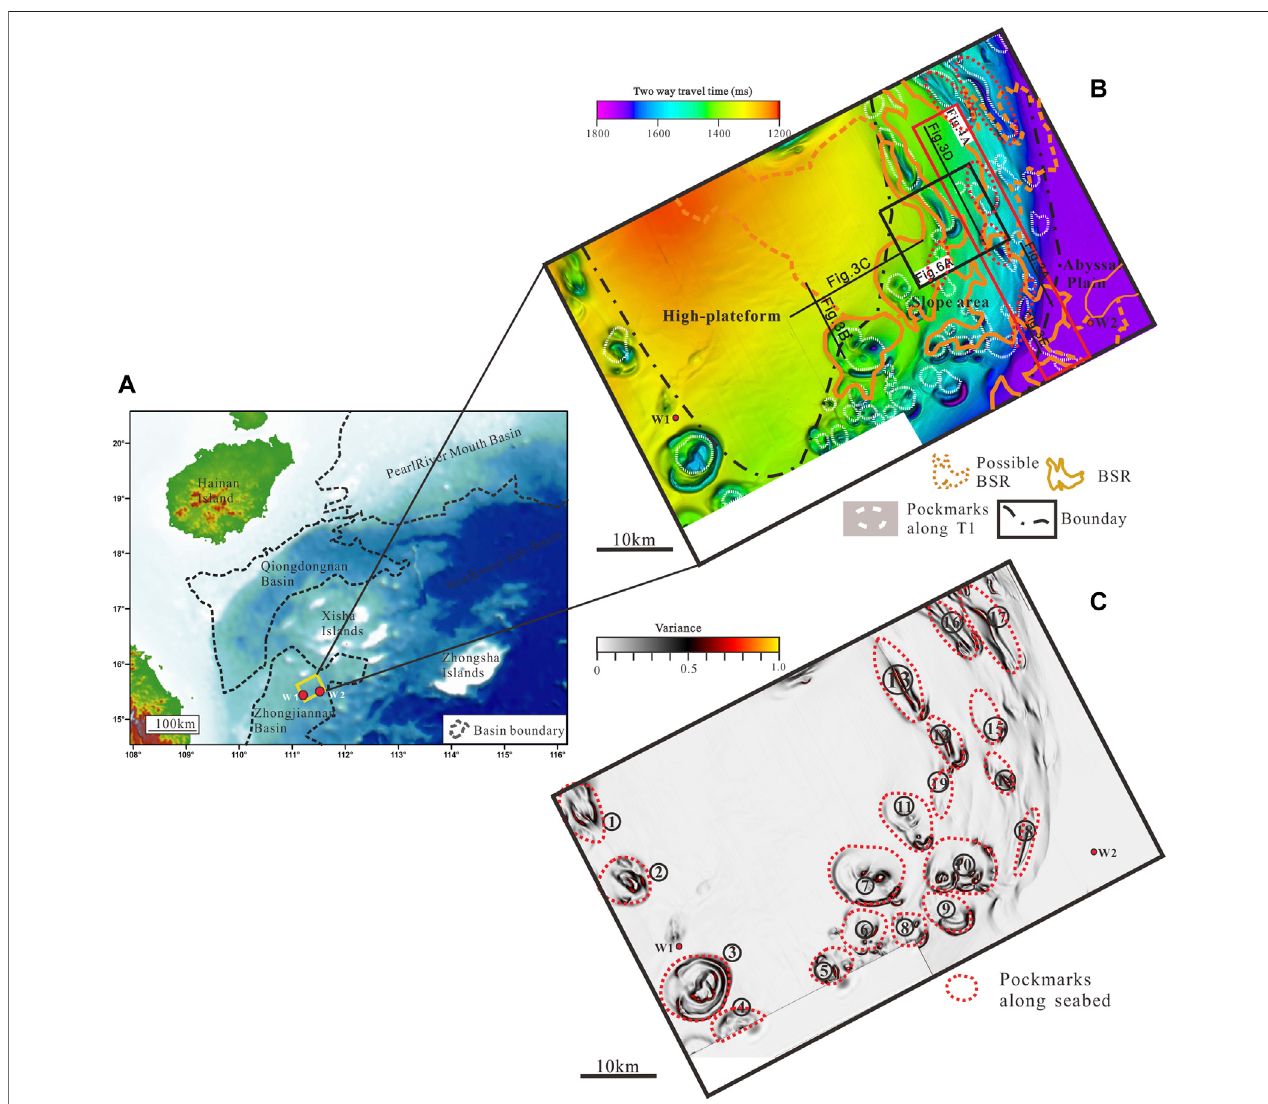
FIGURE 1 | (A) The location of Zhongjiannan basin is to the south of Qiongdongnan basin, the northern slope of South China Sea. (B) The water depth of sea fl oor interpreted from 3D seismic data showing the pockmarks and different types of BSRs. The white break line represents the pockmarks identi fi ed along with horizon T1. Theblackrectanglemarksthelocationofthereprocessed3Dseismicdataboundary. (C) Thevarianceslicealongtheseabedshowingthepockmarks.Theredbreakline represents the pockmarks identi fi ed along with the horizon seabed.